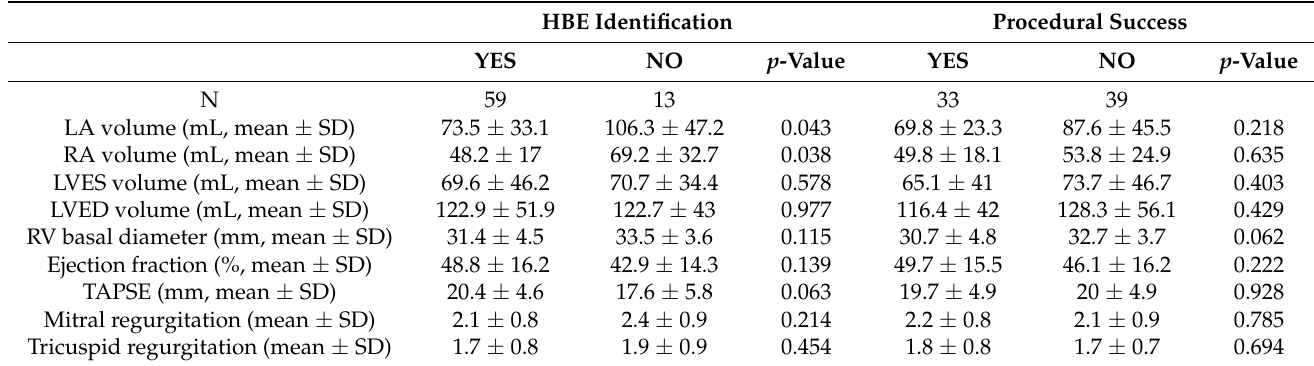
Table 2. Echocardiographic parameters for different study